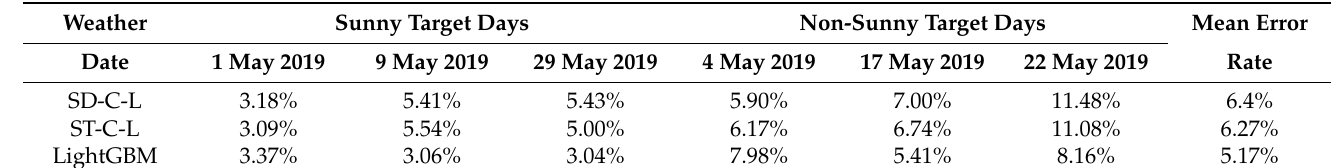
Table 4. Comparison of prediction error rates for different methods.